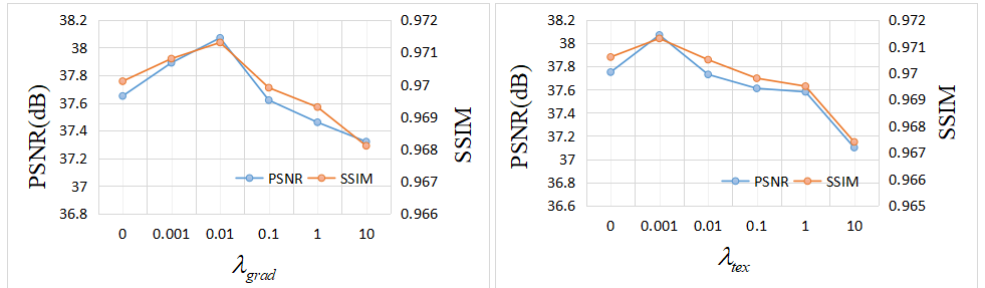
Figure 9. Hyper-parameter analysis on the DIV2K